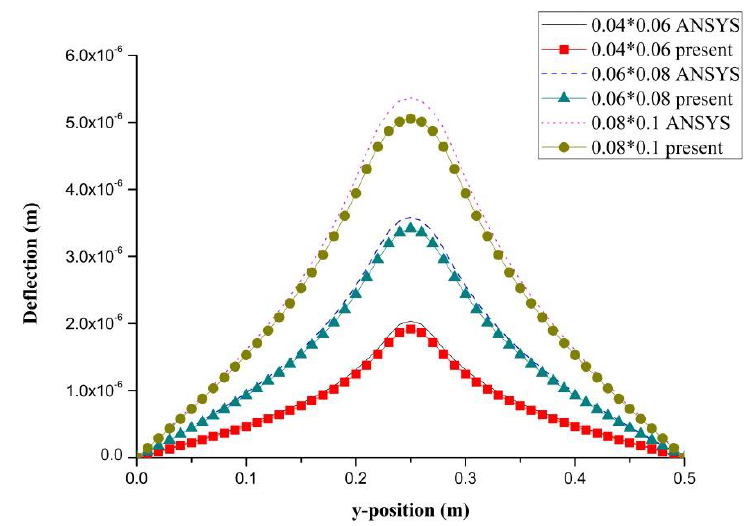
Figure 7. Deflection along the vertical line (x = 0.25 m) of the composite laminate plate induced by a PZT actuator with three different sizes.